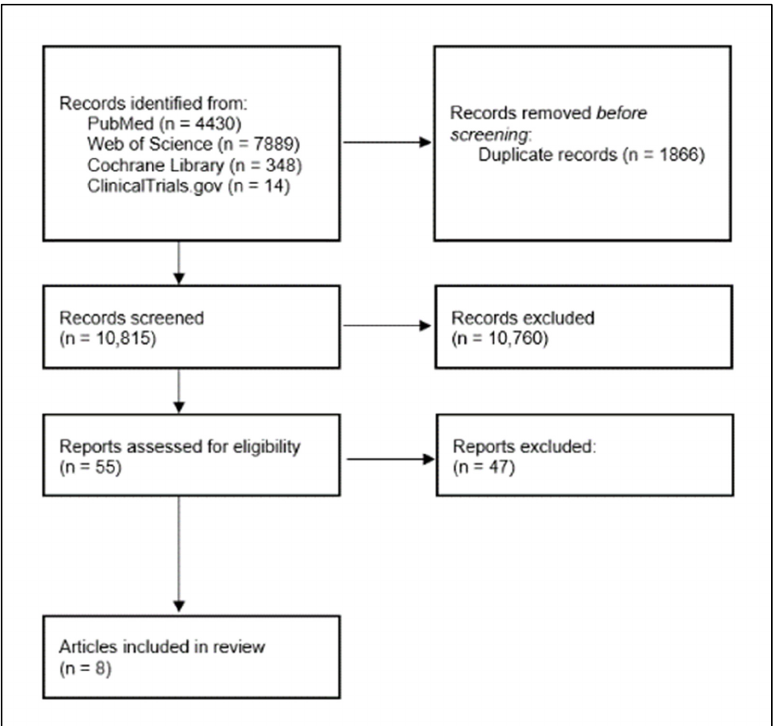
Figure 2. Systematic review flow diagram.